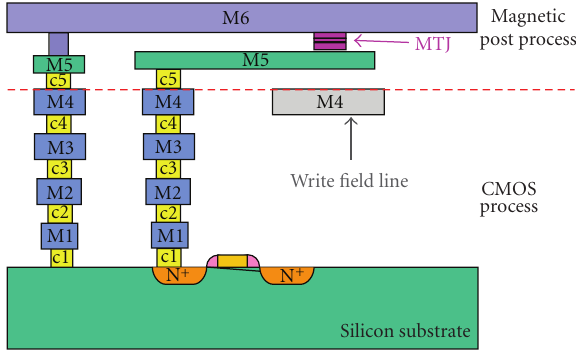
Figure 17: Cross-section of the stacking of the CMOS process and the magnetic postprocess.